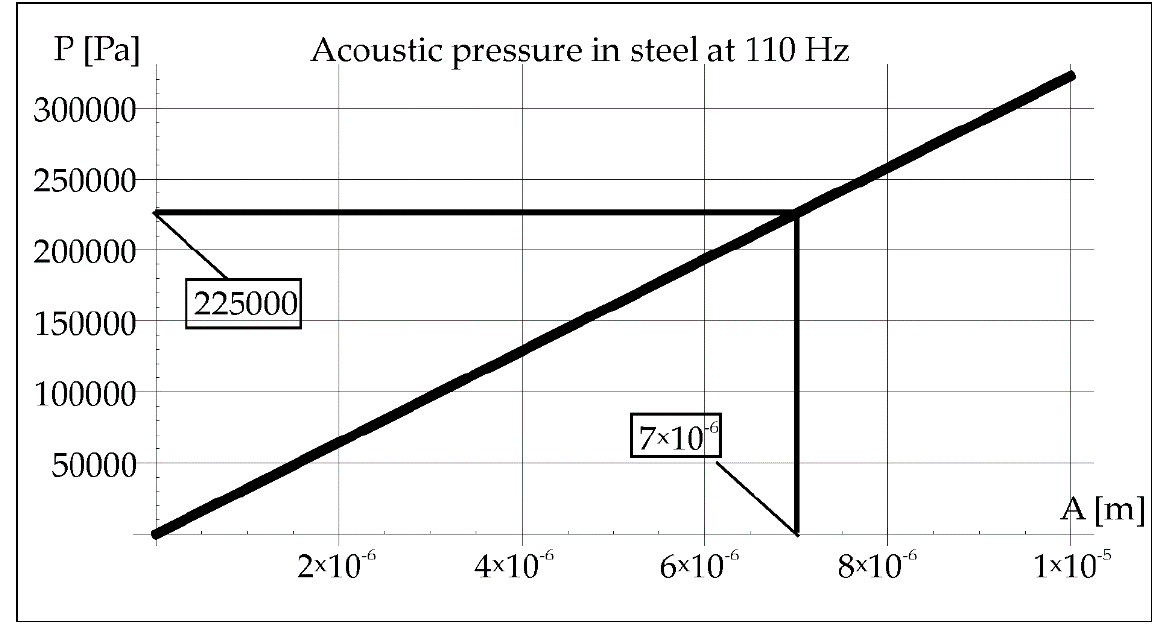
Figure 9. Acoustic pressure in steel at resonance frequency 110 Hz. The crystallization time of the molten metal pool (0.00242 s) calculated from Formula (1) allows to determine the course of the vibration wave in steel from the relation (3) (Figure 10).